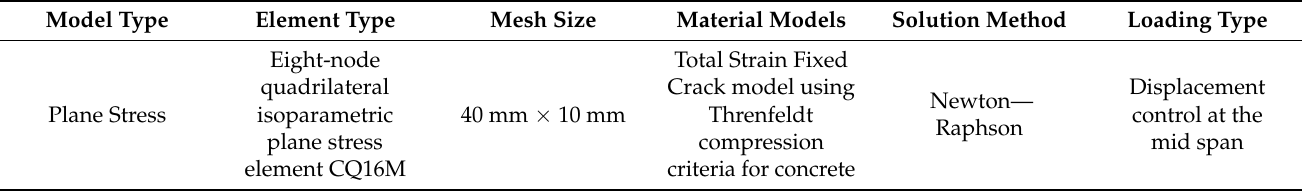
Table 4. Details of the numerical